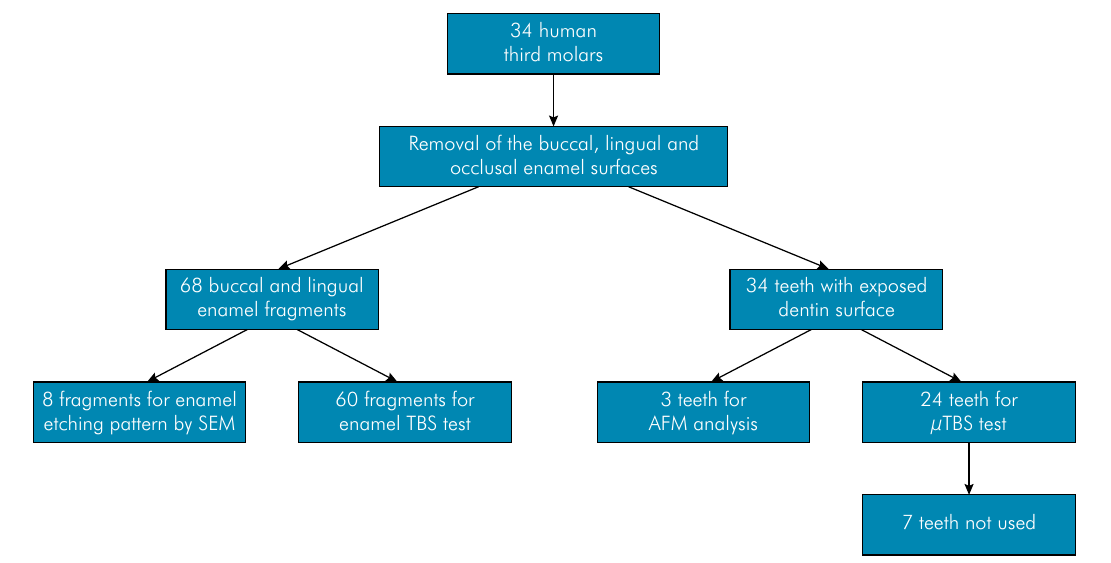
Figure 1. Schematic diagram of the study